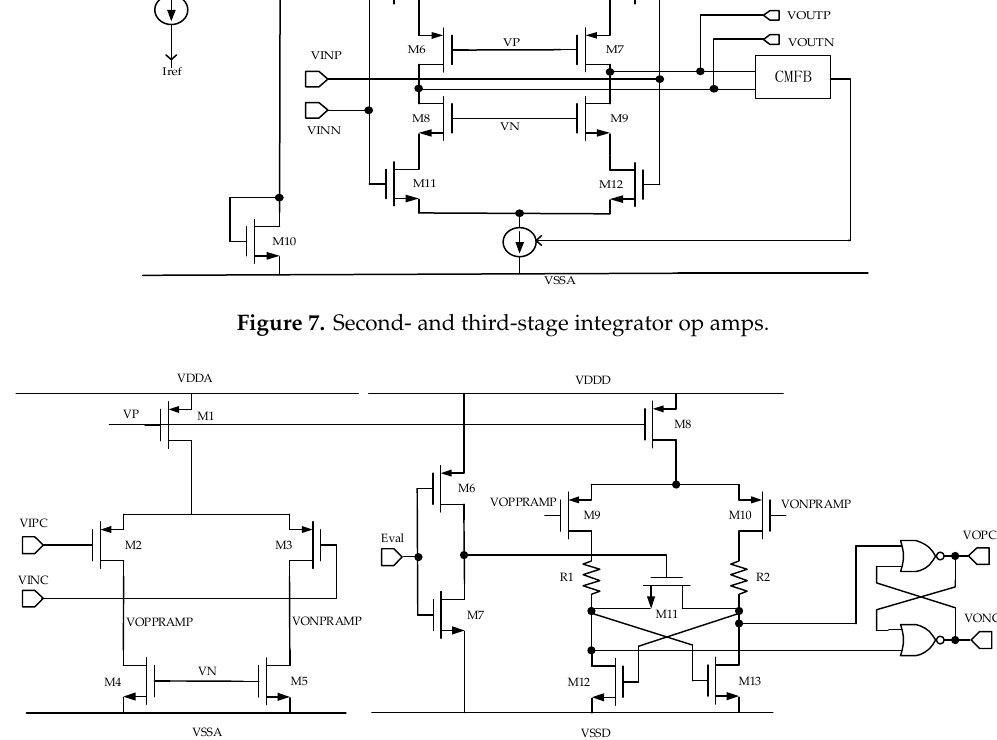
Figure 7. Second- and third-stage integrator op amps.